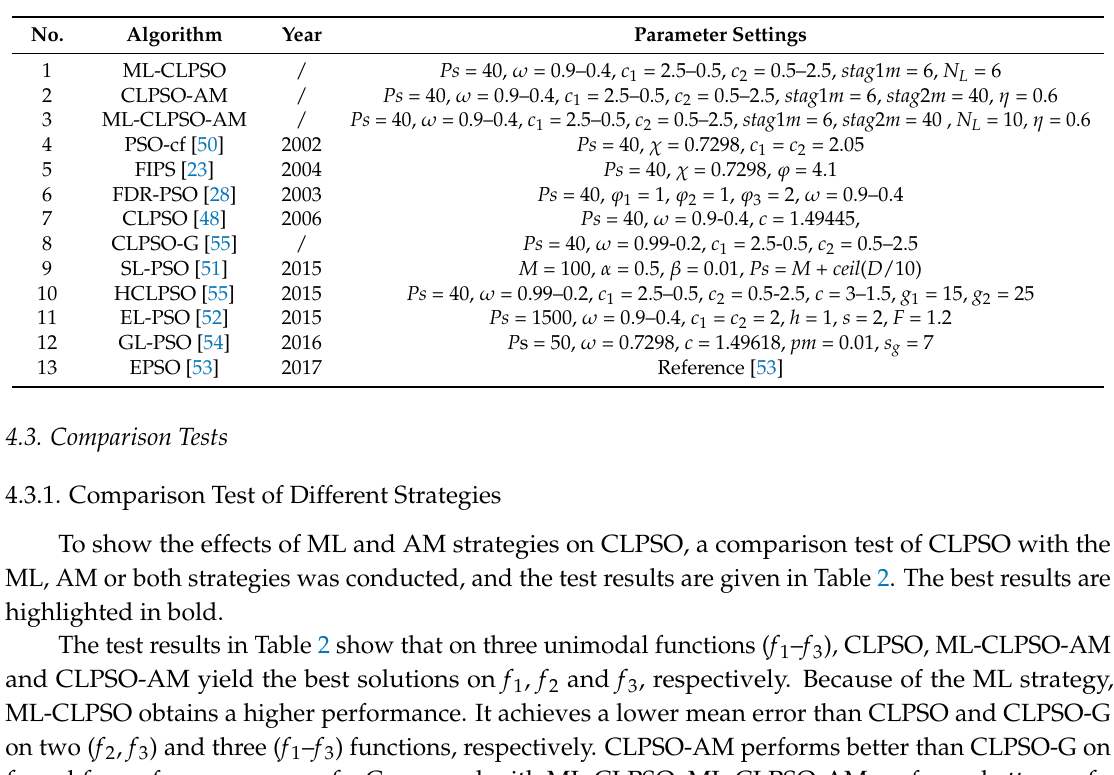
Table 1. Parameter settings of PSO